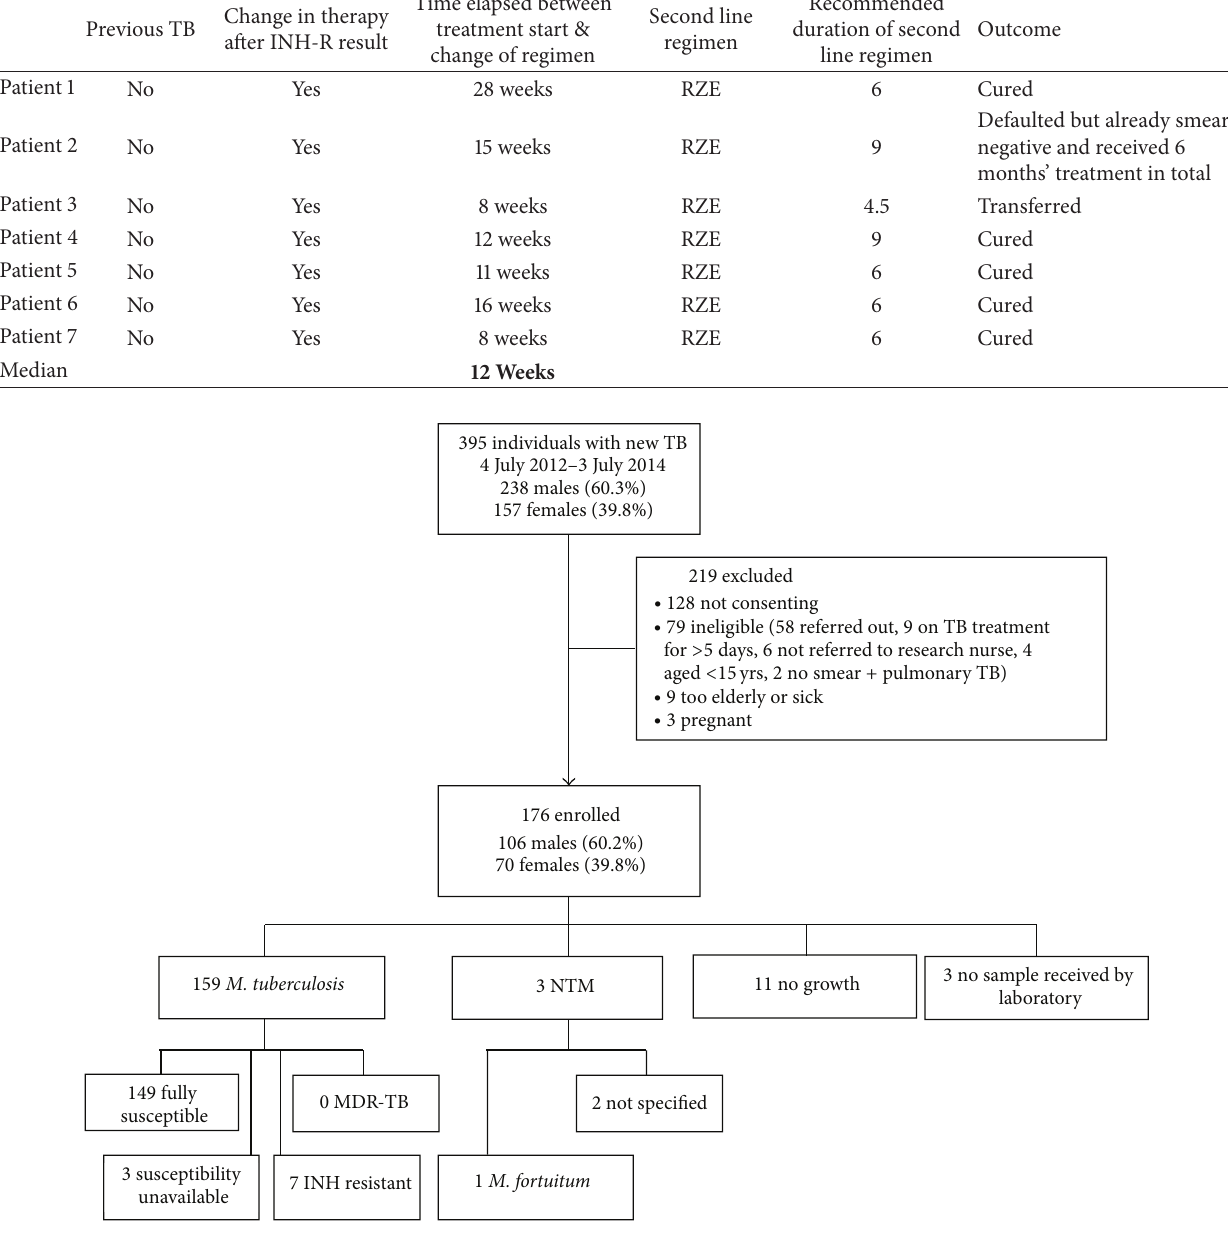
Figure 1: Outpatient study diagram showing enrolment and microbiological